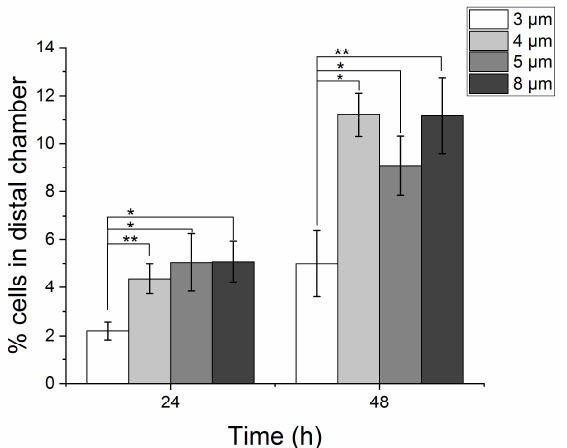
Figure 4. Assessment of primary myoblast migration over 24 and 48 h across microchannel widths of 3, 4, 5 and 8 µm and consistent length of 100 µm. The percentage of cells in the distal chamber was calculated as the ratio of number cells in the distal chamber to proximal chamber. Black asterisks are used to denote statistically significant differences (*p < 0.05, **p< 0.01) and error bars represent standard error of the mean (SEM).